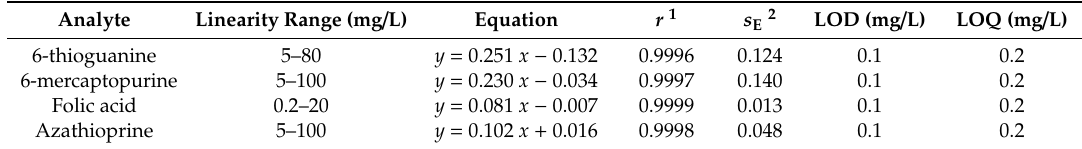
Table 4. Method calibration data.